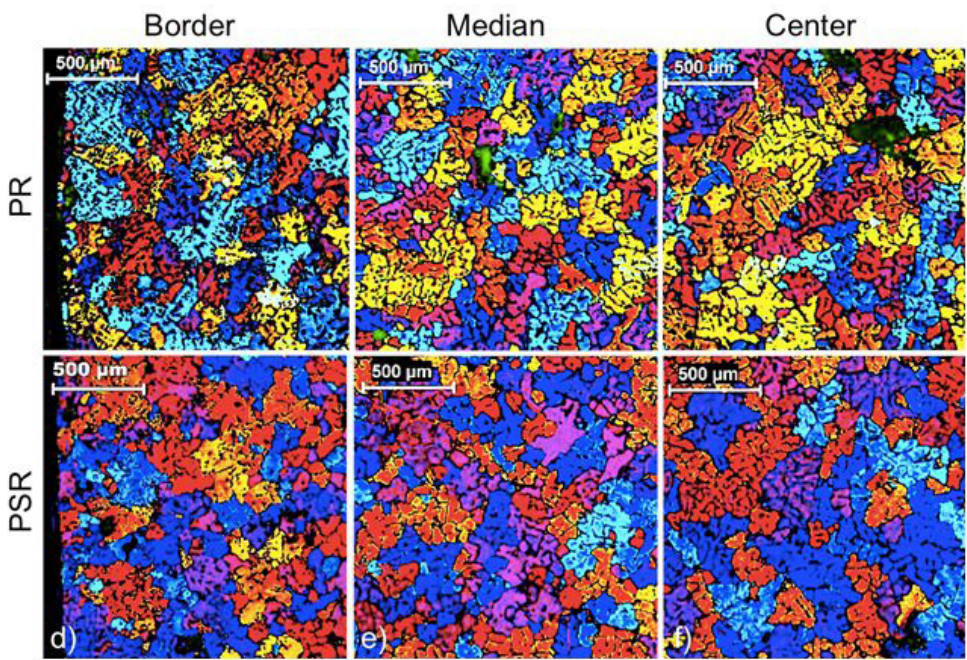
Figure 6. PL microstructure at three locations along a radial cross section of region 1 of an ingot (edge - a, d; middle - b, e; centre - c, f) cast by route 4 with EMS (1500 W) (a-f) and PC (a-c) and PSC